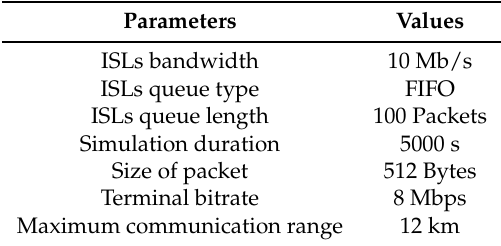
Table 1. Main parameters of satellites in